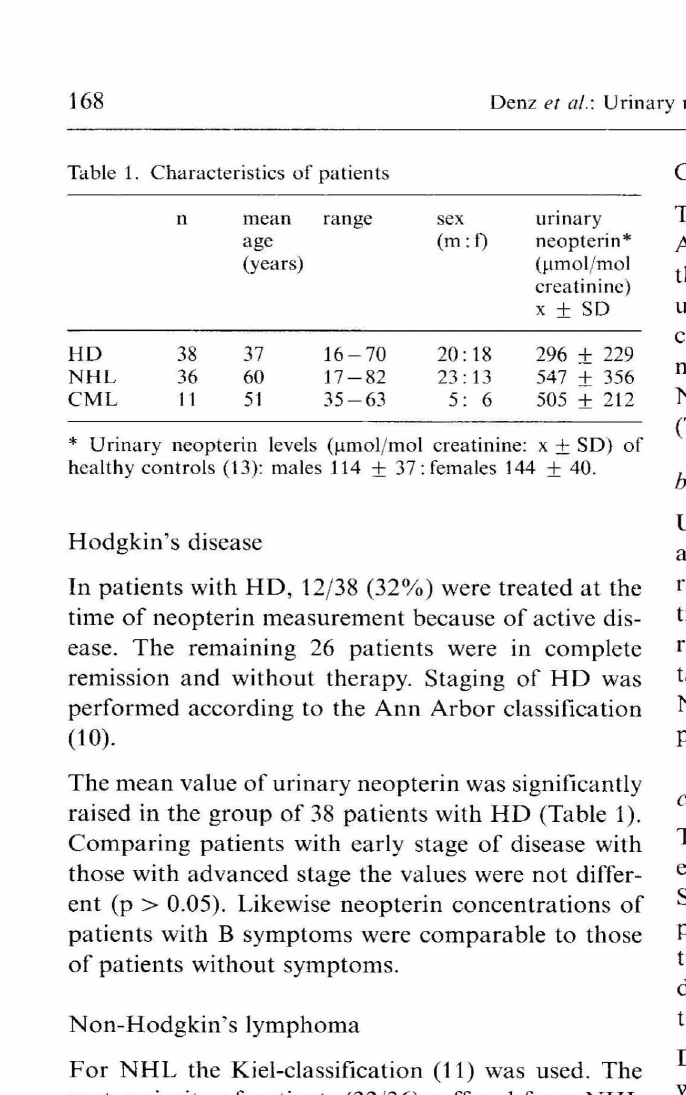
Table 1. Characteristics of patients